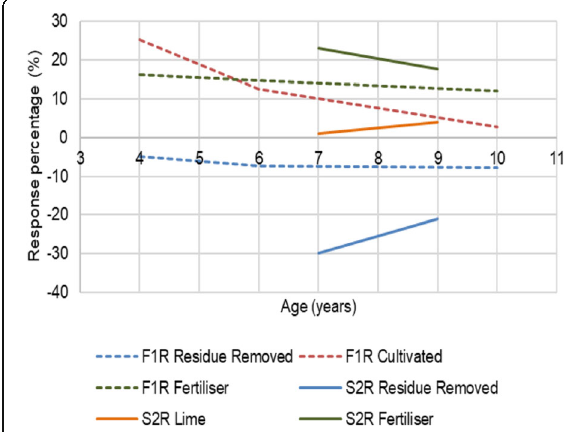
Fig. 3 Relative response compared to the control treatment over time for site preparation and fertiliser application in the first rotation (F1R) established in 1971 (dotted lines) and the second rotation (S2R) on same three sites established in 1991 (solid lines)